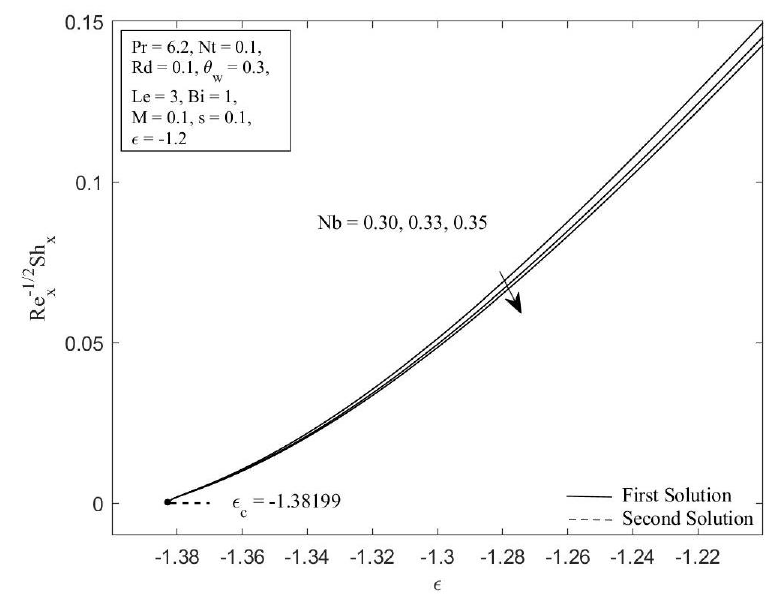
Figure 3. Local Sherwood number 𝑆ℎ 𝑥 𝑅𝑒 𝑥−1 2⁄ against 𝜀 for diverse values of 𝑁𝑏 .